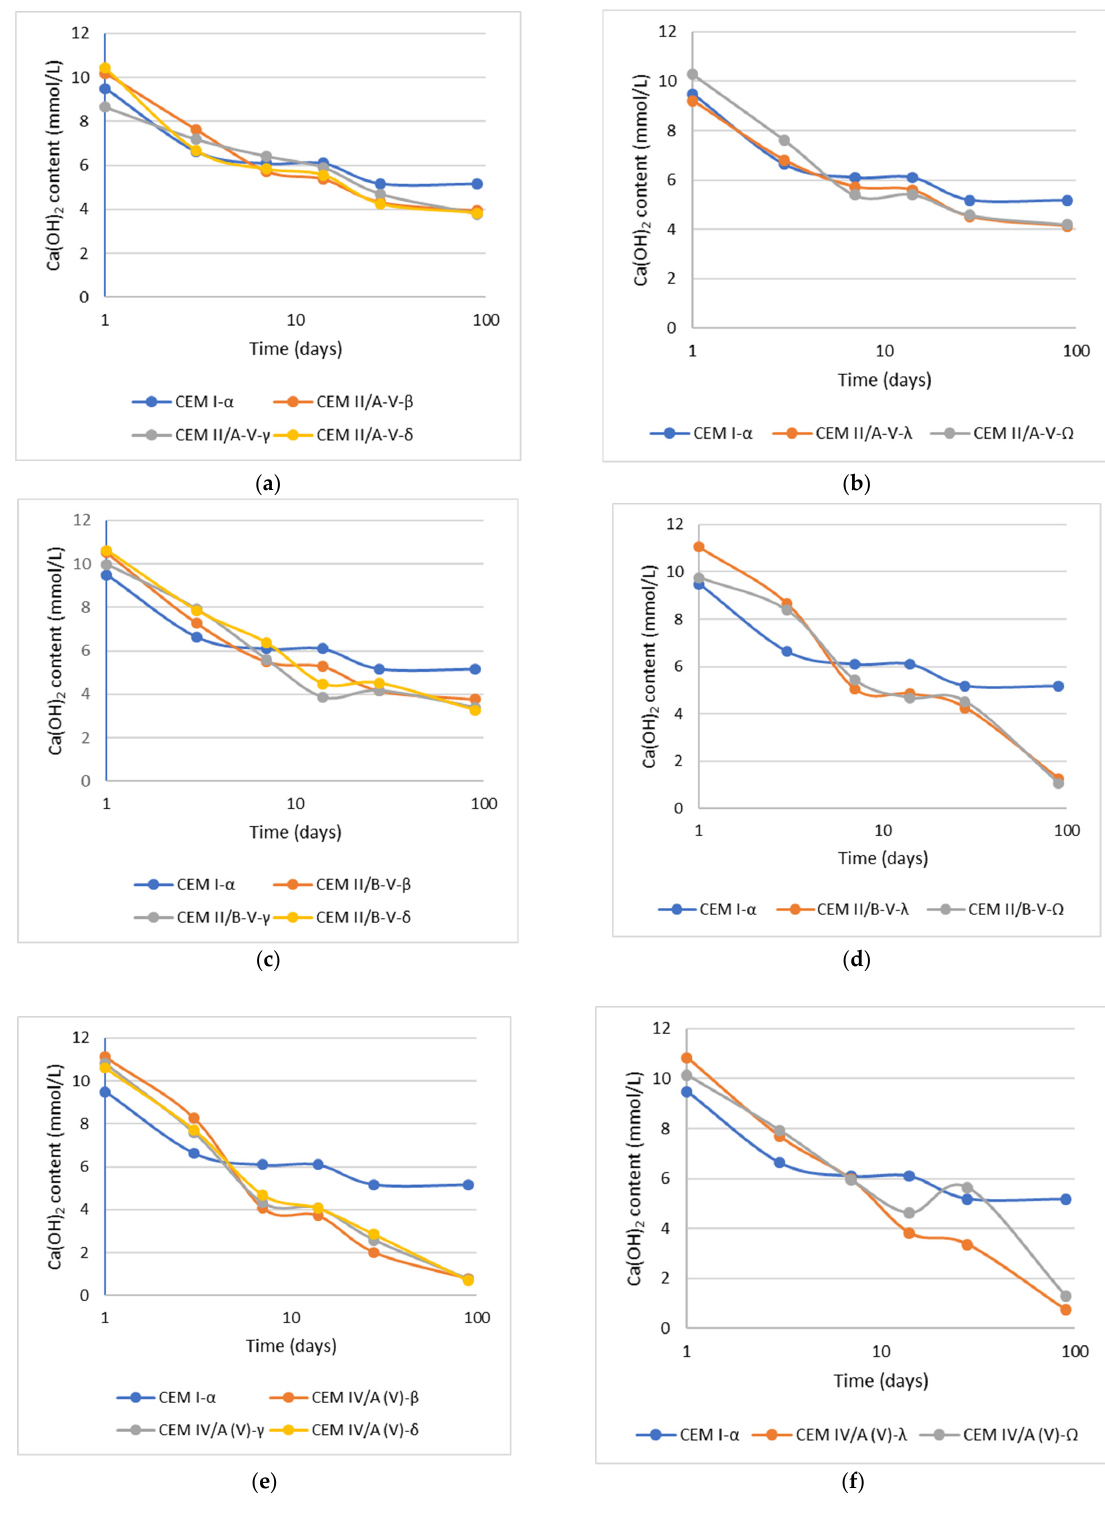
Figure 9. Calcium hydroxide (Ca(OH) 2 ) content of mortars: ( a ) CEM I ( α ) and CEM II/A-V ( β , γ , δ ); ( b ) CEM I ( α ) and CEM II/A-V ( λ , Ω ); ( c ) CEM I ( α ) and CEM II/B-V ( β , γ , δ ); ( d ) CEM I ( α ) and CEM II/B-V ( λ , Ω ); ( e ) CEM I ( α ) and CEM IV/A (V) ( β , γ , δ ); and ( f ) CEM I ( α ) and CEM IV/A (V) ( λ , Ω ).